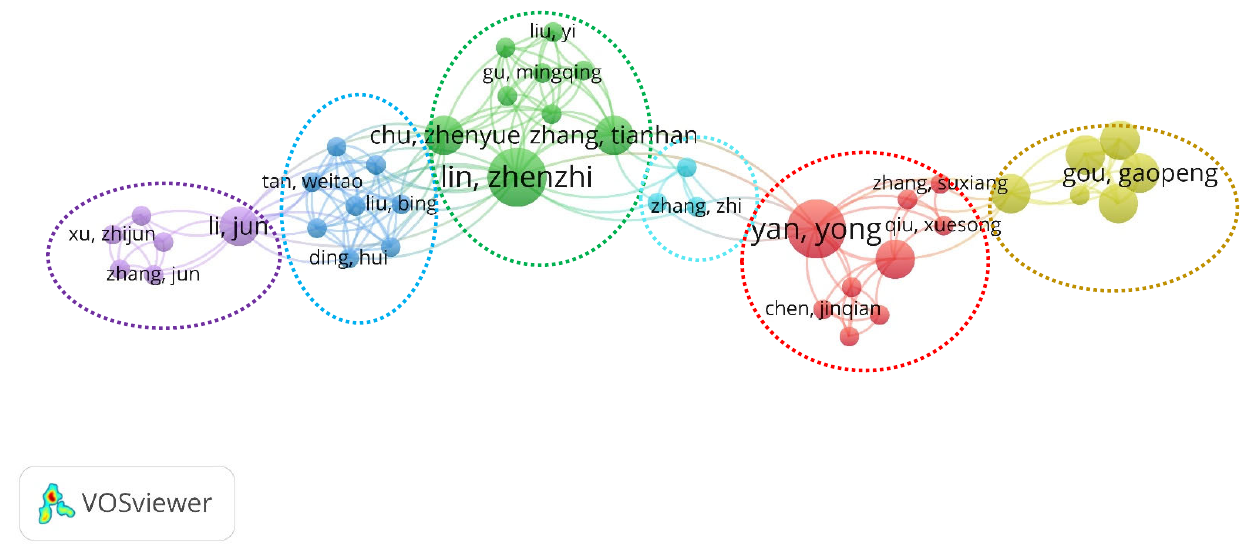
Figure 5. Network visualization of co ‐ authorship.